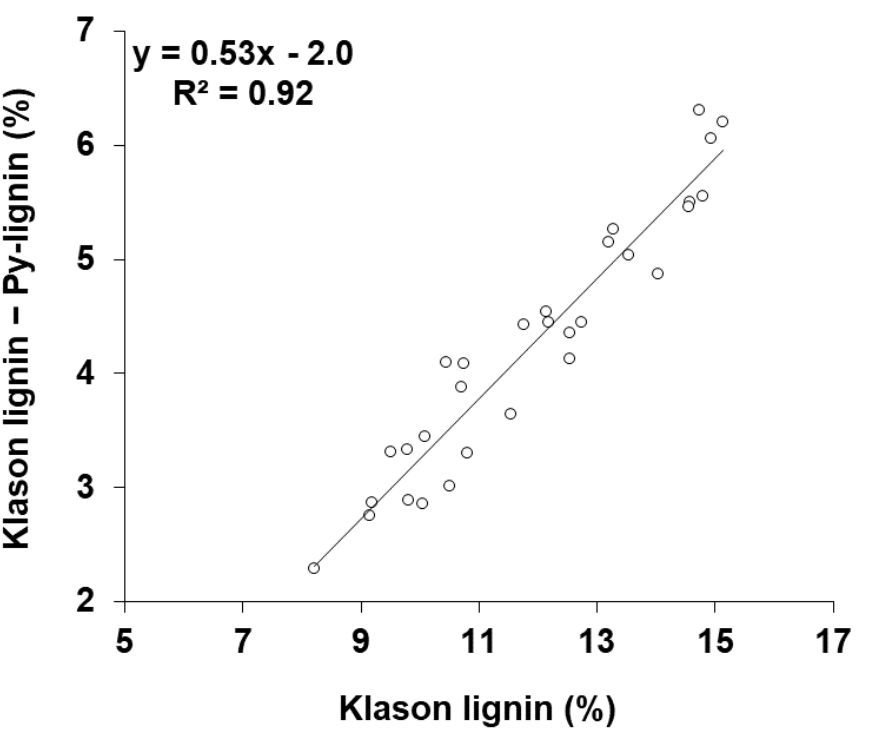
Figure 1. Plot of the difference between the lignin content determined by Klason lignin and Py-lignin content against Klason lignin content.